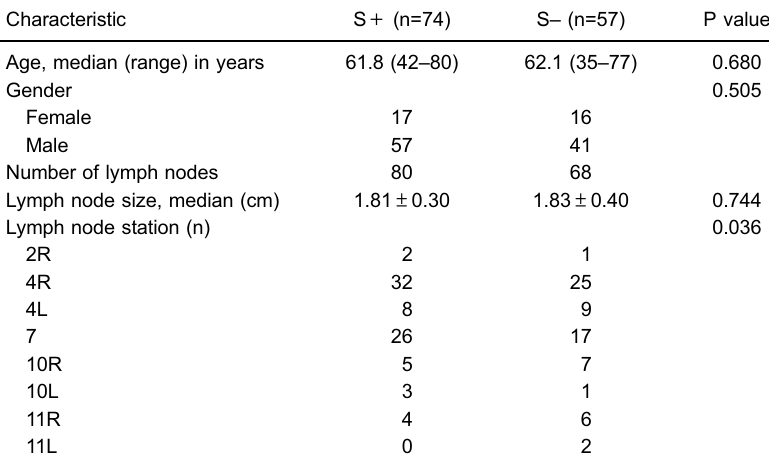
Table 2. Baseline characteristics of patients and lymph